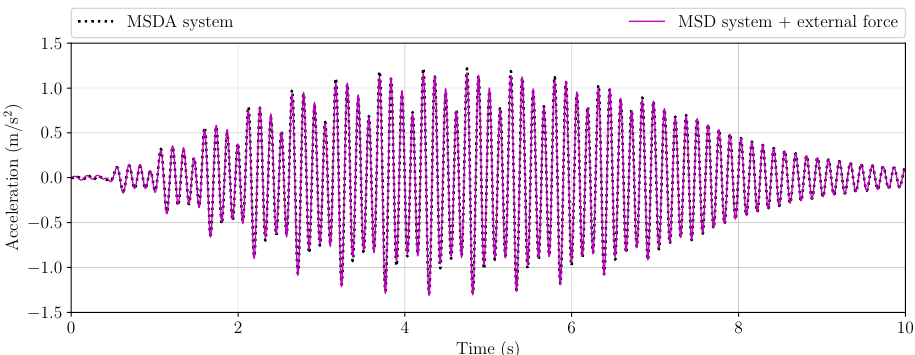
Figure 13. Comparison of the numerical acceleration response at midspan of the FRP footbdige using two HSI